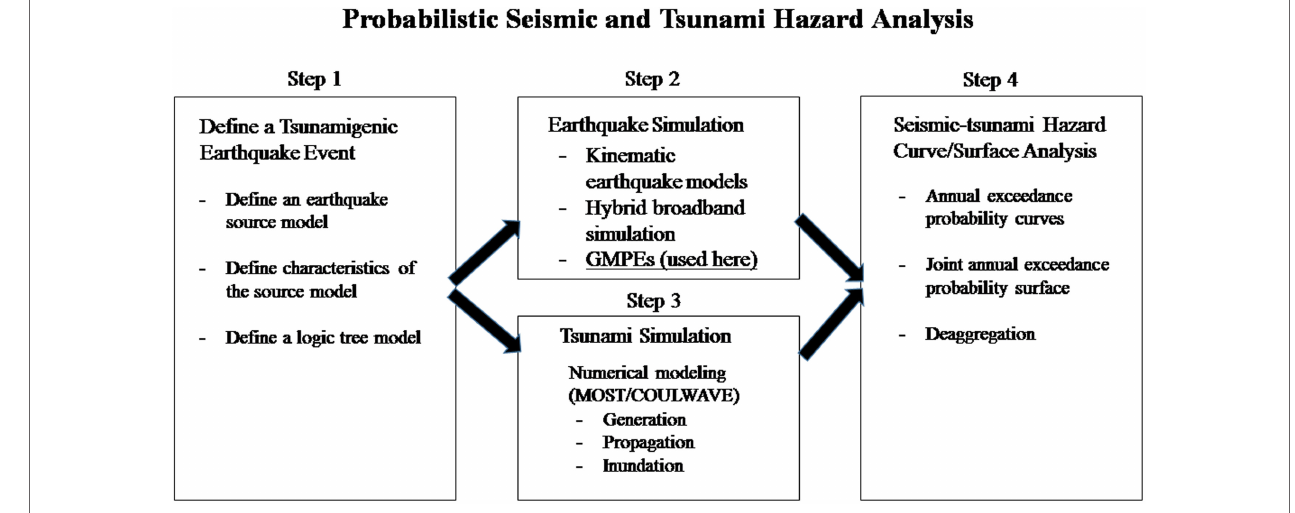
FIGURE 1 | Flow chart of methodology used for probabilistic seismic and tsunami hazard